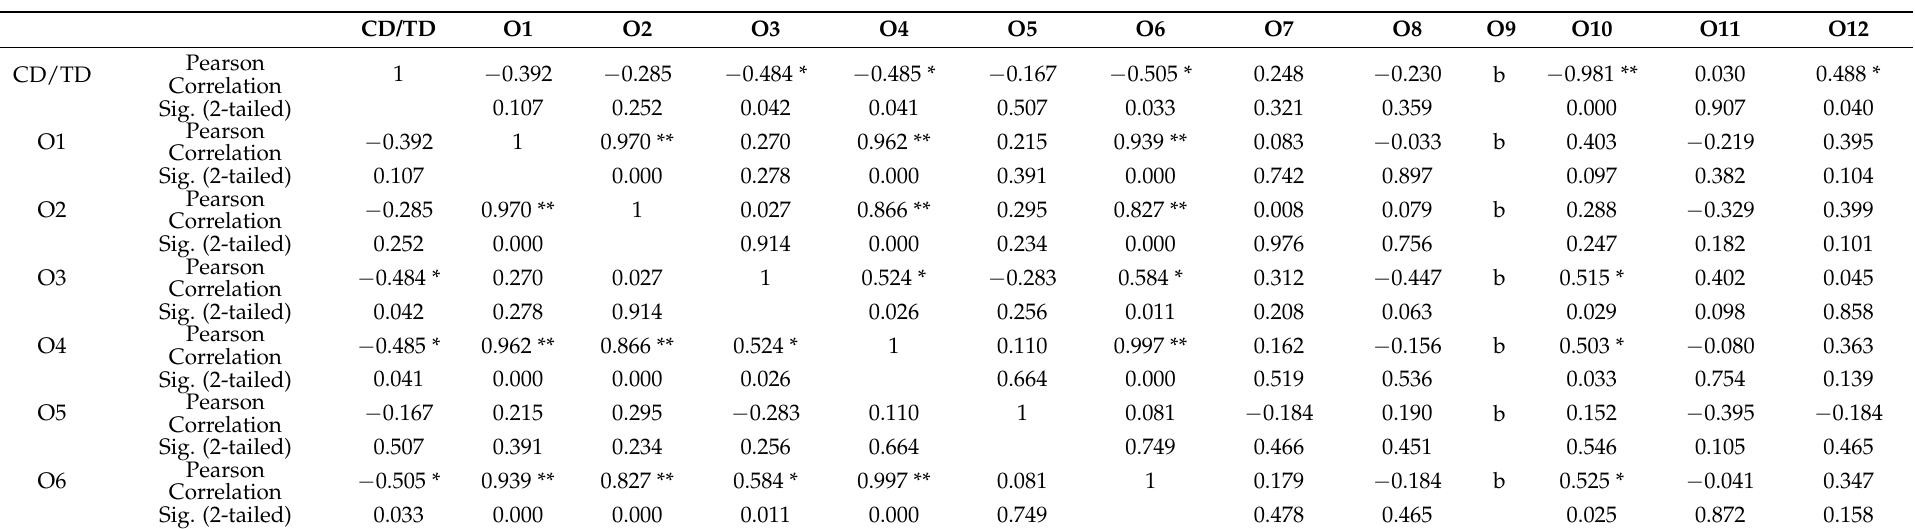
Table 7. Correlation of CD/TD ratio with O1-O12